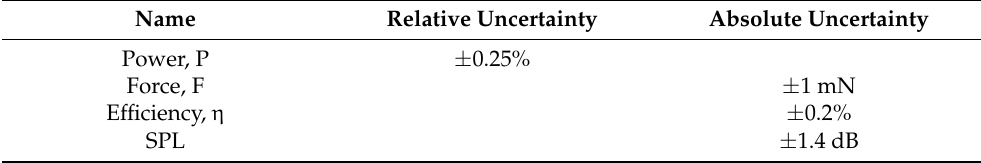
Table 2. Measurements uncertainty.